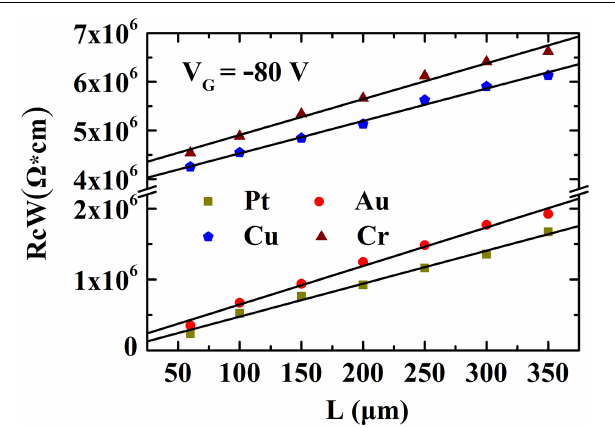
FIGURE 3 | The normalized contact resistance ( R C × W ) and the linear fitting results of top-gated IDT-BT OFETs with different channel length and with Pt, Au, Cu, and Cr contact metal,